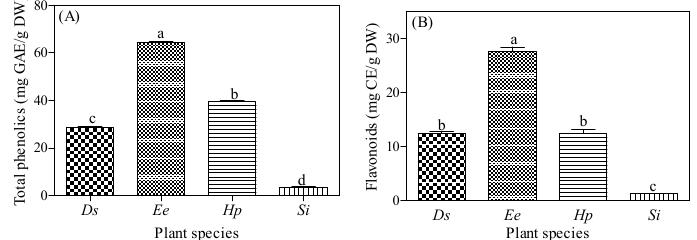
Figure 1. Total phenolic and flavonoid contents of 50% methanol extracts of four plants used by Batswana traditional healers to treat skin diseases. Ds = Drimia sanguinea , Ee = Elephantorrhiza elephantina , Hp = Helichrysum paronychioides , and Si = Senecio longiflorus . In each graph, the bars with different letter(s) are significantly ( p ≤ 0.05) different based on Tukey’s Multiple Comparison Test. Each bar represents mean ± standard error, and n = 3.